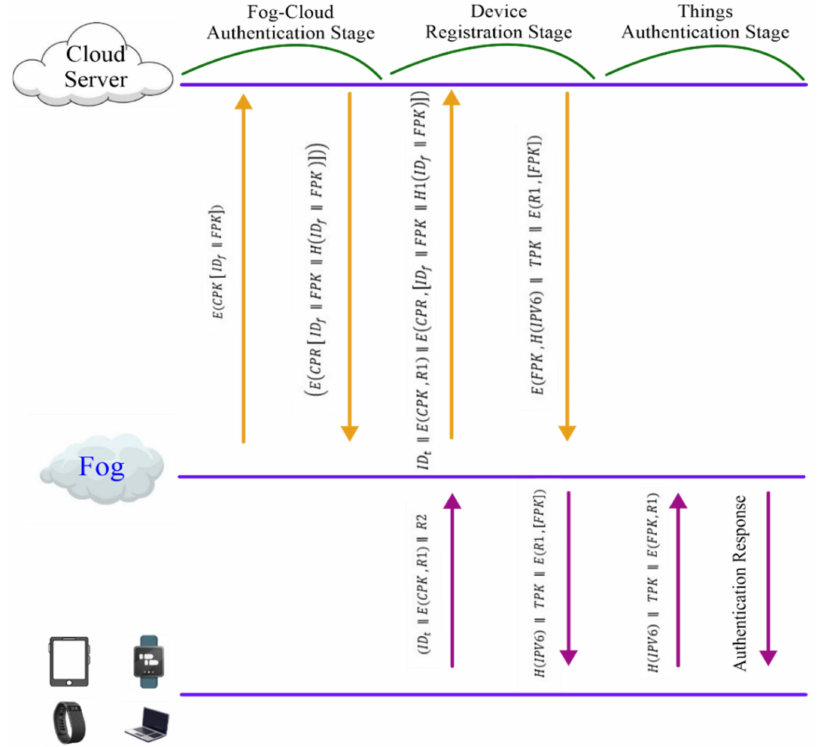
Figure 3. Flowchart of the planned authentication